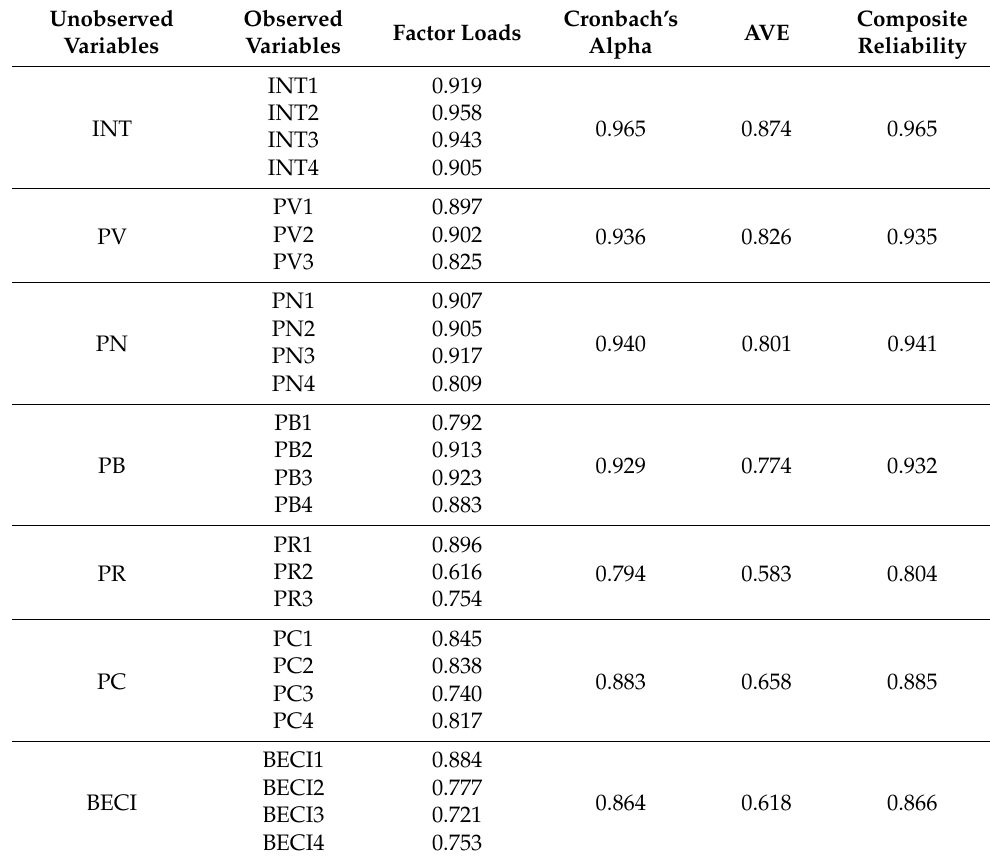
Table 1. Results of measurement model